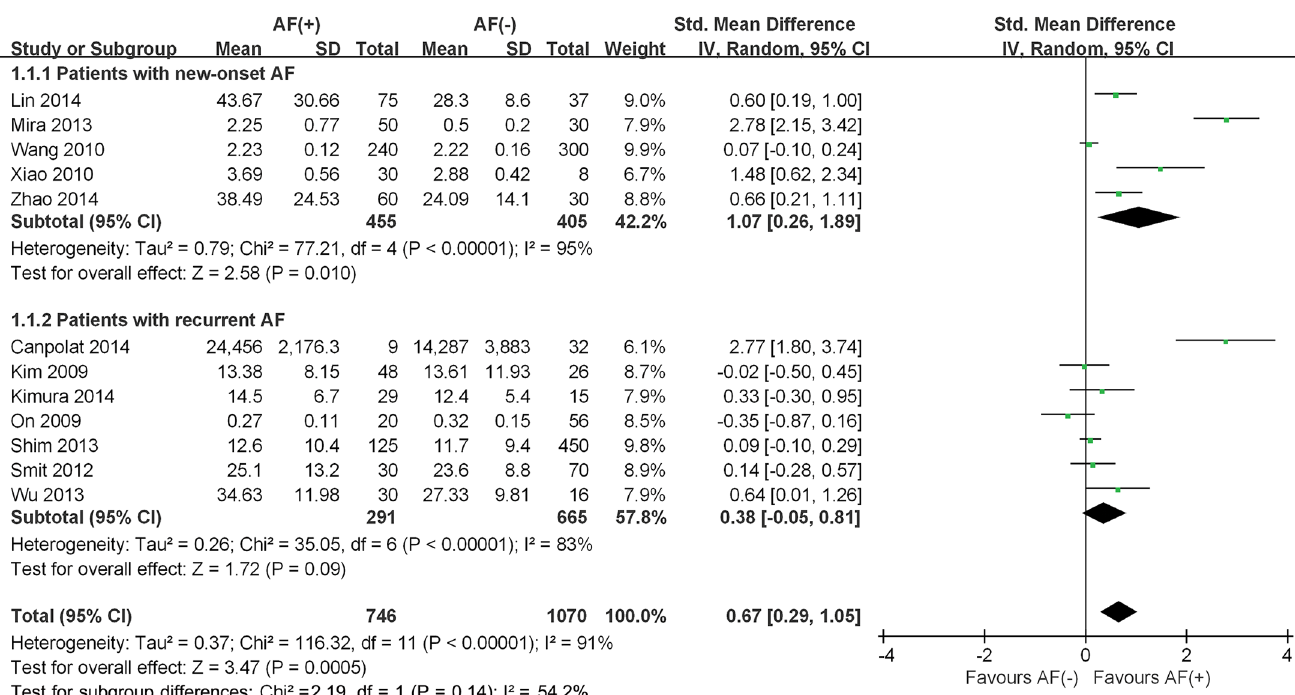
Fig 2. Forest plot of the association between the plasma level of TGF- β 1 and AF occurrence depending on different study population in which TGF- β 1 levels were analyzed as continuous variable. AF, atrial fibrillation; CI, confidence interval; SD, standard deviation.